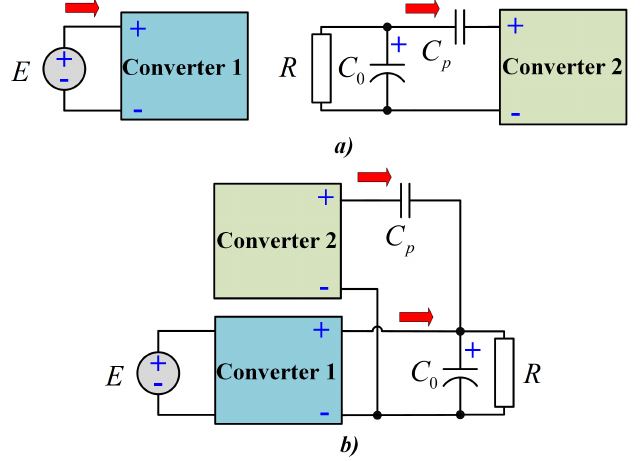
Figure 4. Power flows of the proposed configuration: ( a ) Equivalent scheme when both inductor are storing energy, and ( b ) equivalent scheme when both inductors are delivering energy.